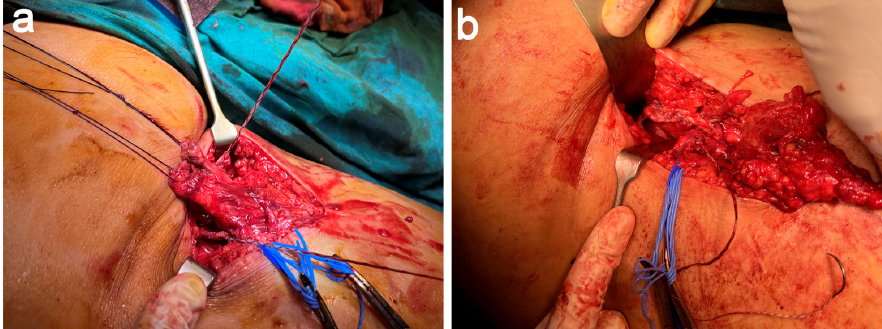
Figure 5. Semitendinosus tendon allograft placement. ( a ) Support with Ribbon resistance band. ( b ) Allograft to tendon suture.